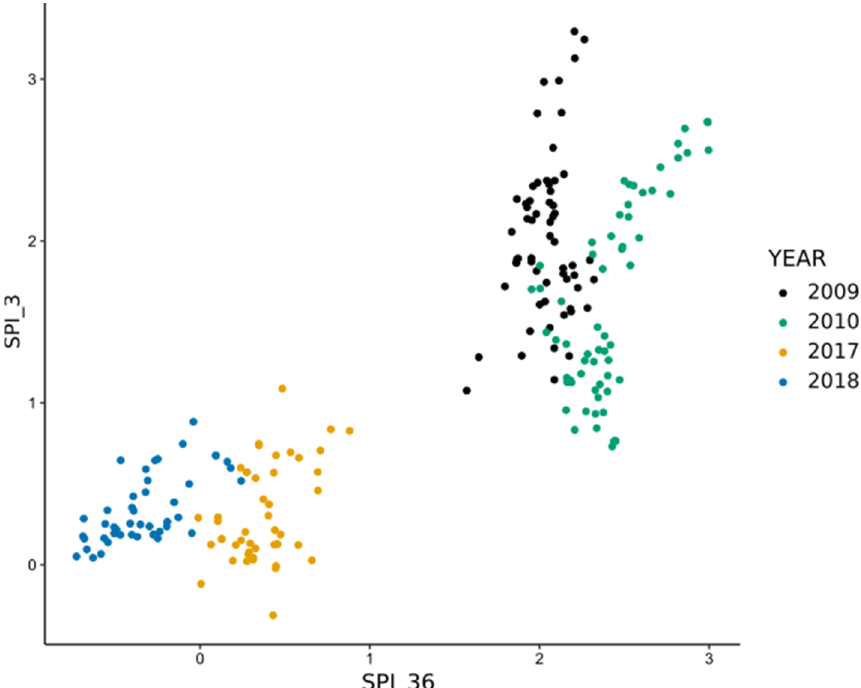
Figure 4. Short-term (SPI_3) and long-term (SPI_36) precipitation conditions over the study sites in 2009, 2010, 2017, and 2018. (See Figure S3 for a black and white version.).